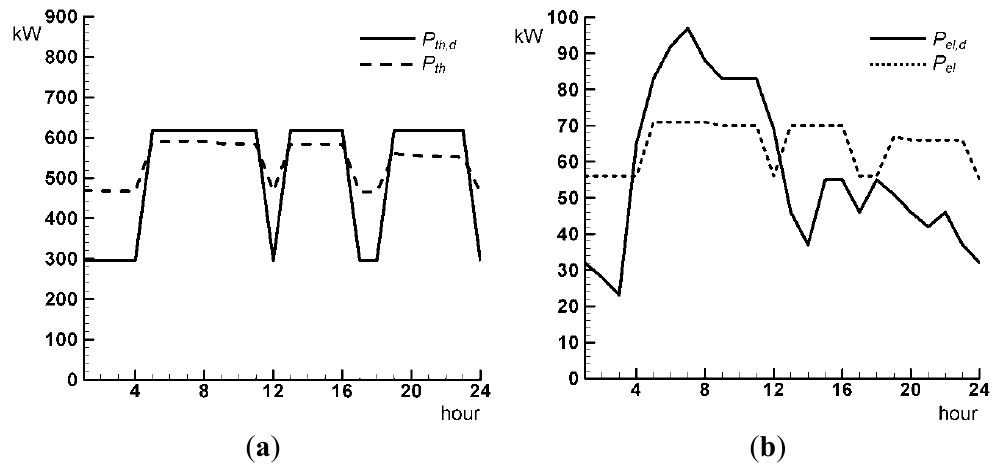
for a typical winter day.